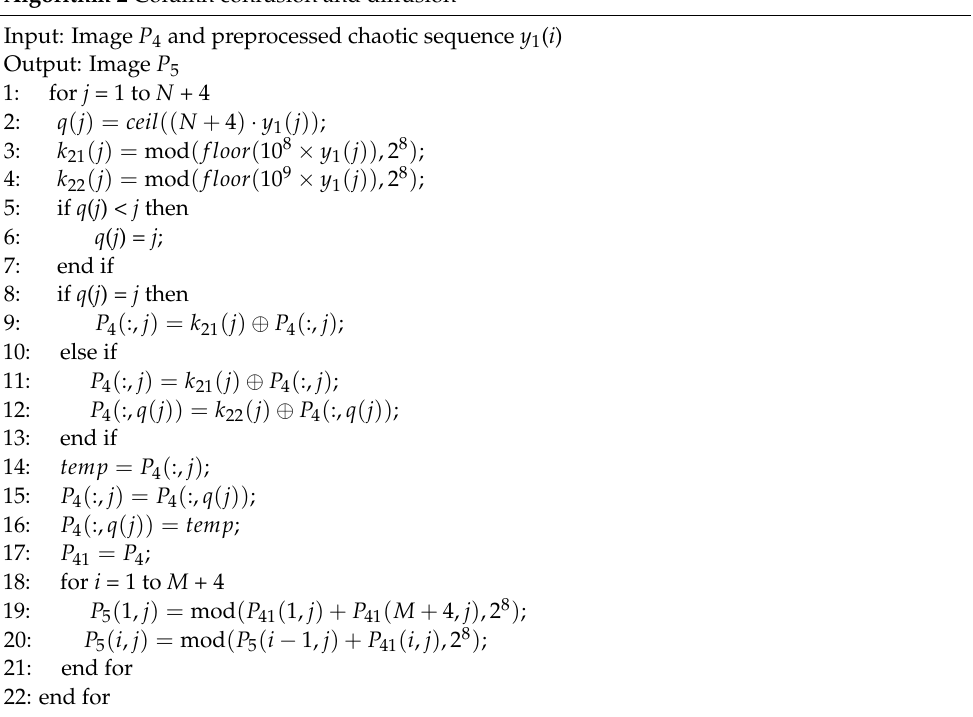
Algorithm 2 Column confusion and